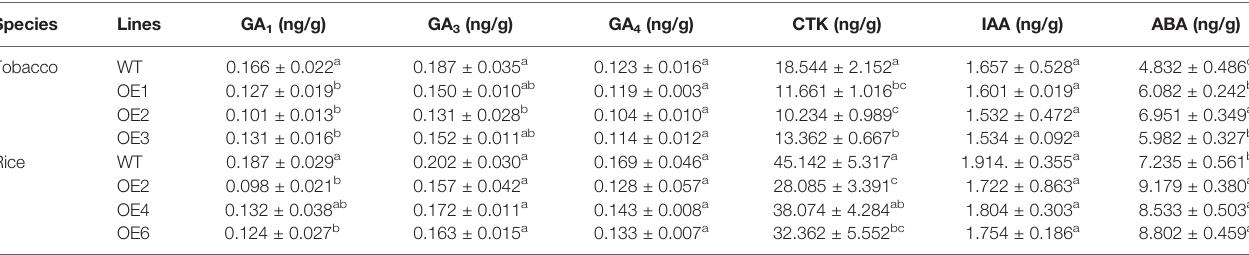
TABLE 5 | Measurement of phytohormone contents in wild-type and ZmMYB59 transgenic lines Species